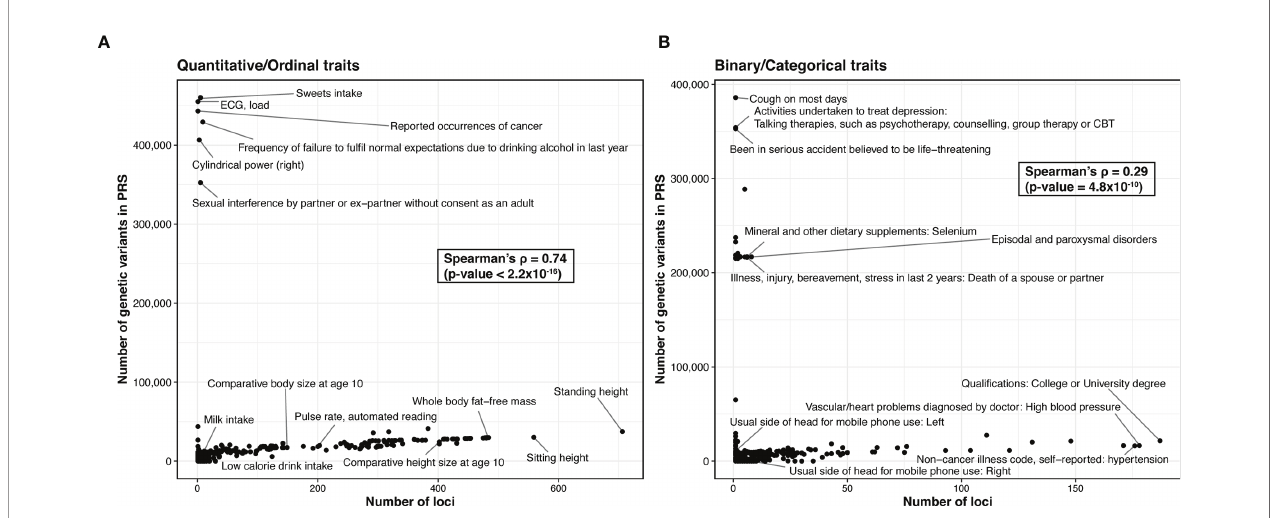
FIGURE 4 | Comparison of the trait polygenicity and the PRS model size. (A) Quantitative/ordinal traits. (B) Binary/categorical traits. We apply LASSOSUM across GWAS analysis of the UK biobank data (round 2) from http://www.nealelab.is/uk-biobank/. We exclude traits that have no signi fi cant variant (p < 5×10 -8 ). For binary/categorical traits, we further excluded traits with number of cases ≤ 5000. In total, we created polygenic risk score models for 338 quantitative/ordinal traits and 454 binary/categorical traits. We used number of loci identi fi ed in UK Biobank as a proxy for the degree of trait polygenicity.